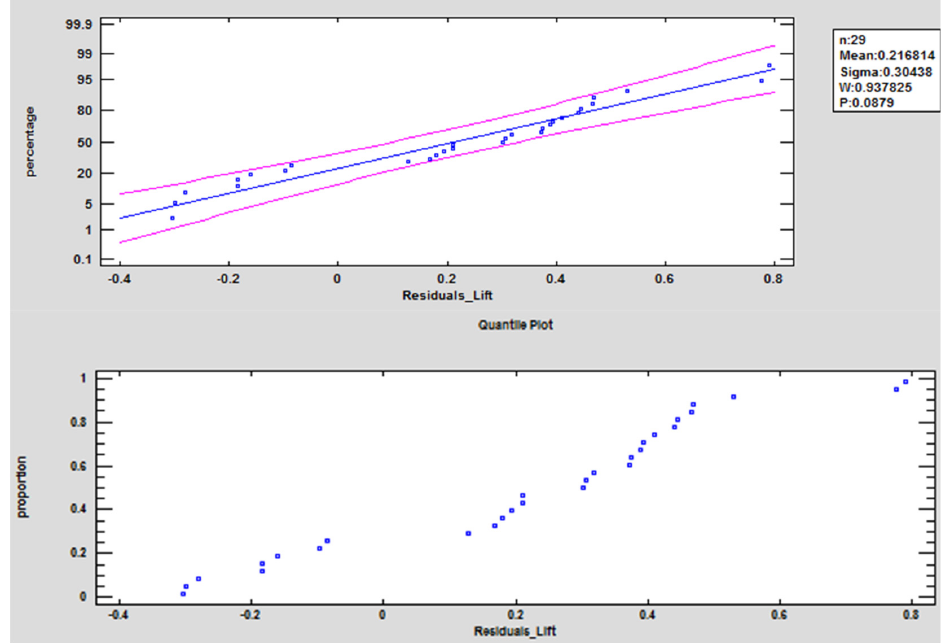
Figure 23. Analysis of the lift forces’ residual values between the wind tunnel and model data.